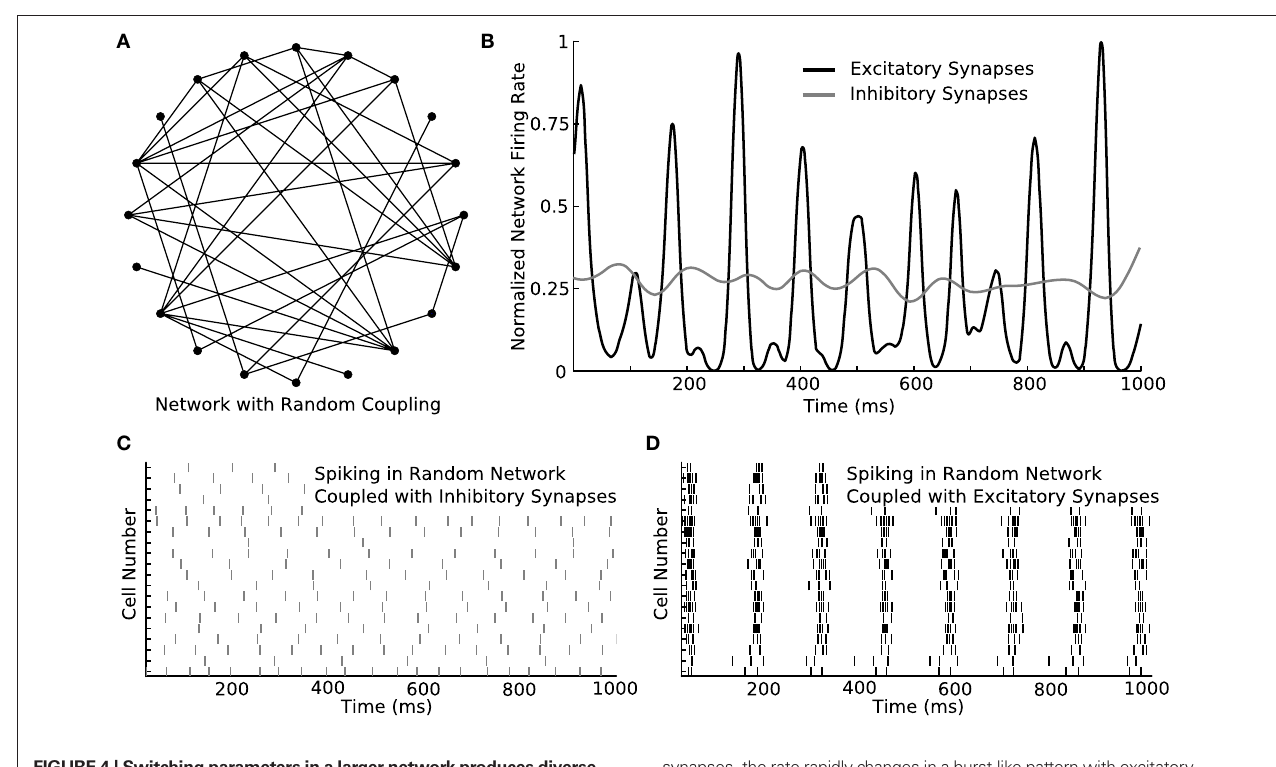
FIguRe 4 | Switching parameters in a larger network produces diverse activity patterns. (A) An example of a larger network containing 20 neurons coupled randomly. In the diagram, filled circles represent cells and lines represent synapses. Synaptic direction is not indicated. The connection probability between each cell pair is 20%. (B) The 20-cell network is simulated with either excitatory or inhibitory synapses. While the total amount of spiking is similar in both simulations, the instantaneous rate differs considerably between the simulations. While the rate is nearly constant over time with inhibitory